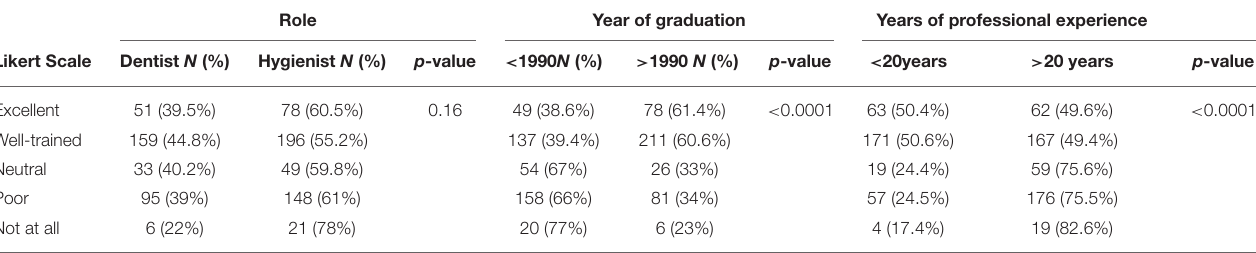
TABLE 2 | Summarize the ratings assigned by the respondents regarding training received at their dental-related schools with respect to managing patients with diabetes with respect to role, years of graduation and years of professional